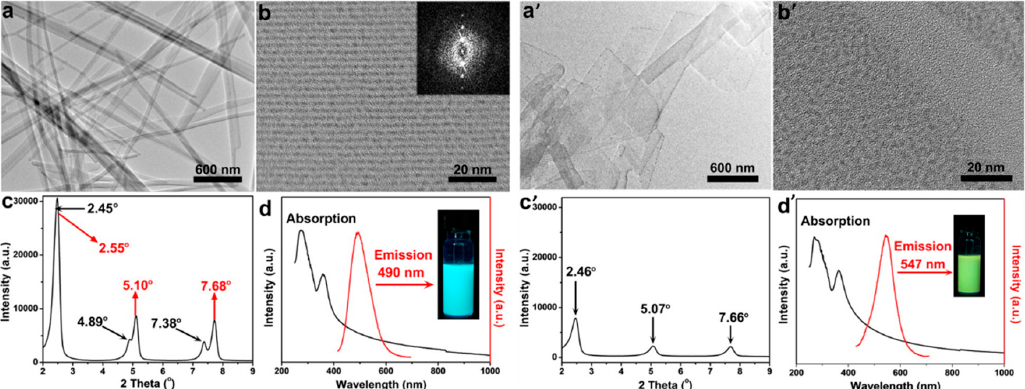
Figure 9. ( a ) TEM image of the ribbons from Cu NCs’ self-assembly. ( b ) HRTEM image of the ribbons. Inset: the Fourier transform image. ( c ) Small-angle region of XRD pattern. ( d ) Steady-state absorption (black) and emission (red) spectra of the ribbons in chloroform. Inset: the fluorescent image with 365 nm excitation. ( a’ ) TEM image of the sheets from Cu NCs’ self-assembly. ( b’ ) HRTEM image of the sheets. ( c’ ) Small-angle region of XRD pattern. ( d’ ) Steady-state absorption (black) and emission (red) spectra of the sheets in chloroform. Inset: the fluorescent image with 365 nm excitation. Reprinted with permission from Ref. [45]. Copyright (2015) American Chemical Society.